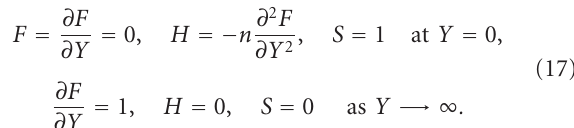
Equations (16) are subjected to boundary